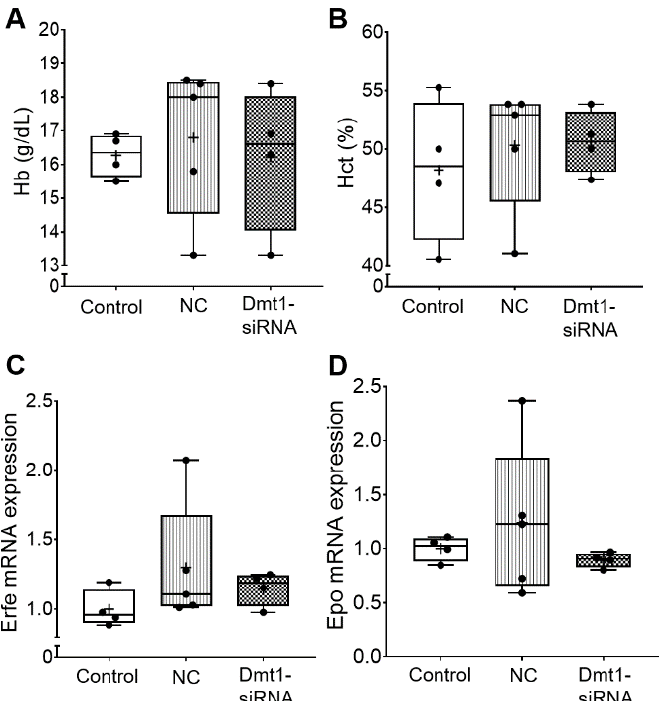
Figure 3. Hematological parameters in the blood and erythropoietic demand were not affected in experimental mice by Fa-GDLVs/siRNA exposure. Blood, bone marrow and kidney were collected and analyzed. Hb ( A ) and Hct ( B ) in whole blood were measured. Erfe mRNA expression in bone marrow ( C ) and Epo mRNA expression in kidney ( D ) were also analyzed. Data are presented as box plots for n = 4–5 mice per group. No statistically significant differences were noted between groups (as determined by one-way ANOVA). NC, negative control; +, mean value.